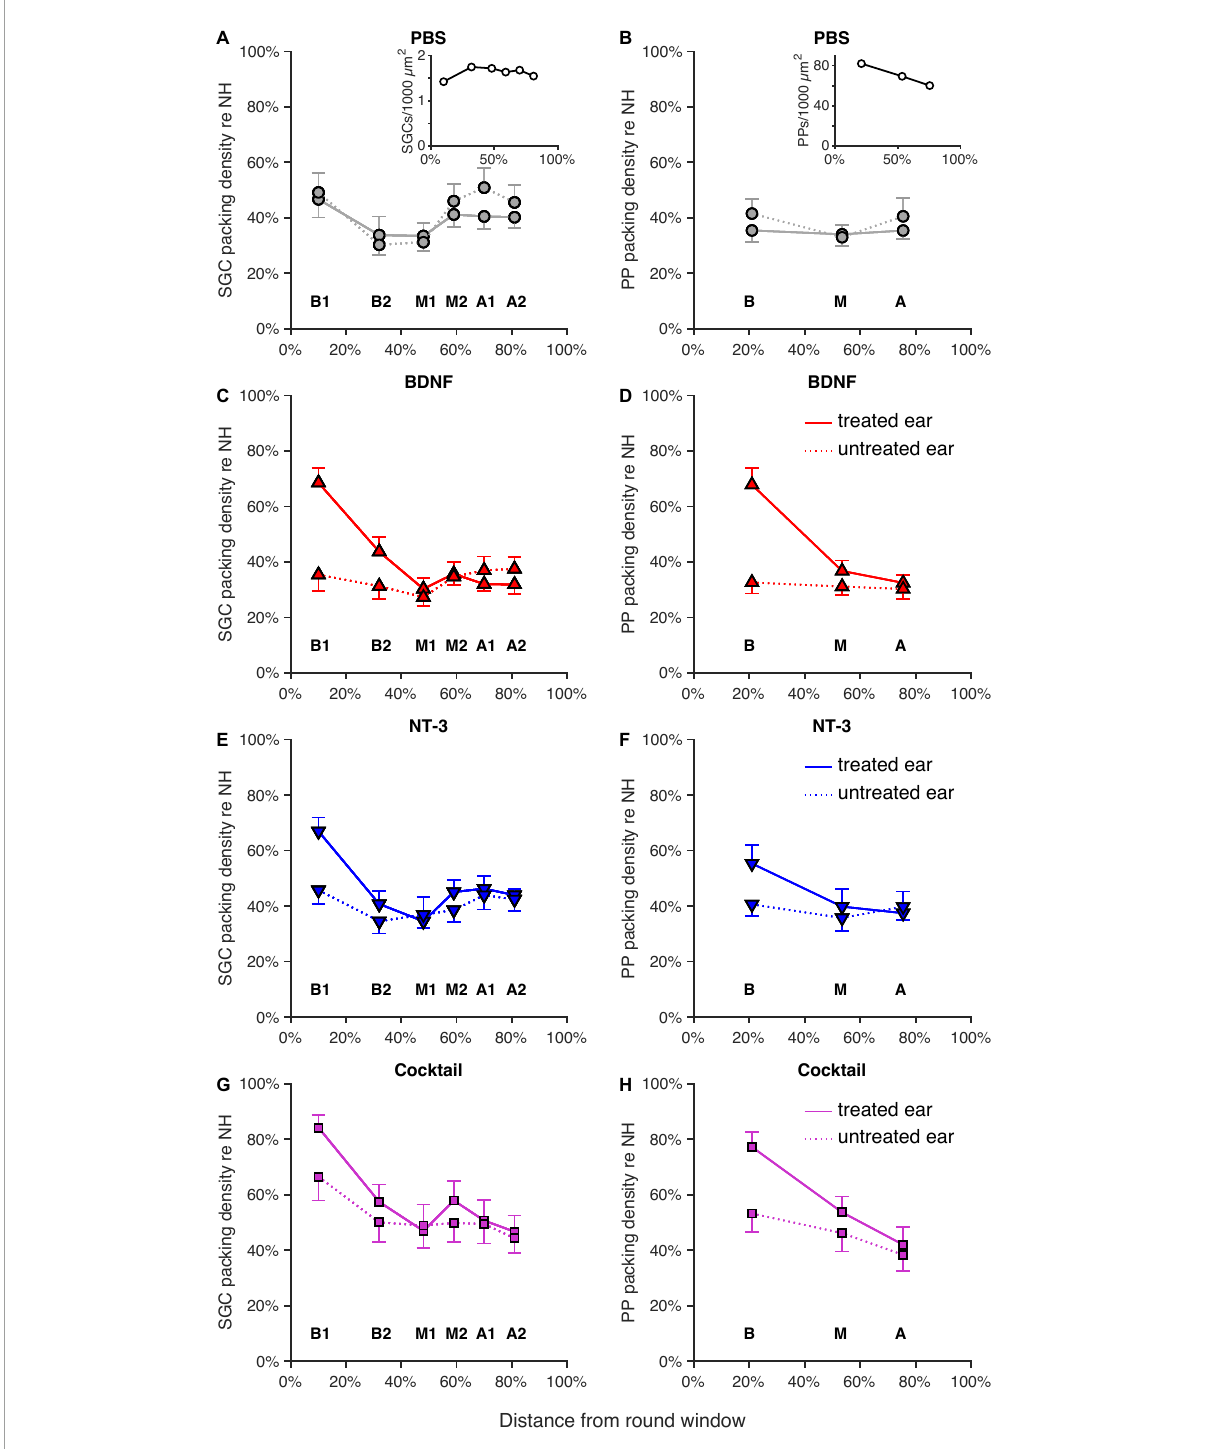
FIGURE3 Normalized SGC and PP packing densities as a function of cochlear location as a relative distance to the round window, with 0% as the round window membrane and 100% being the helicotrema. Group means of SGC (left column) and PP (right column) packing densities for both the treated right ears (solid lines) and the untreated left ears (dotted lines) are shown for (A,B) the PBS group ( n = 12; n = 11 for location A in B ), the insets represent the absolute SGC (A) , and PP (B) packing densities for the NH animals, (C,D) the BDNF-treated group ( n = 11), (E,F) the NT-3-treated group ( n = 11; n = 10 for location B1 in F ), and (G,H) the Cocktail-treated group ( n = 12; n = 10 for location B1 in G ; n = 11 for location A in H ). Error bars represent